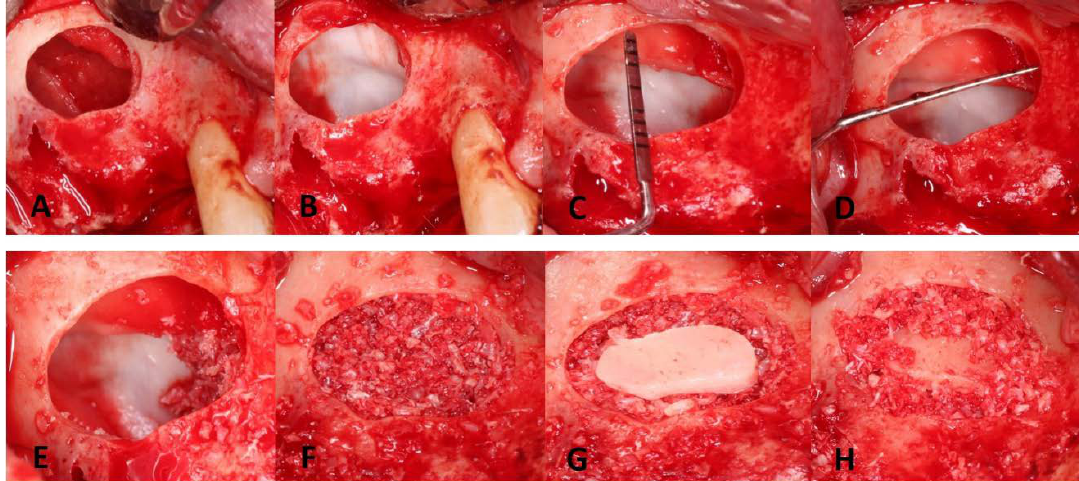
Figure 5. Membrane elevation with perforation repair and bone grafting: ( A ) sinus membrane elevation; ( B ) sinus repair with the first layer of CollaTape; ( C ) apico-occlusal dimension = 10 mm; ( D ) mesiodistal dimension = 10 mm with PRF membrane in place; ( E ) placement of a BioGide membrane to properly seal the perforation site. Note the bone graft on the anterior medial portion; ( F ) bone grafting of the surgical site well packed crestally; ( G ) the bony wall was placed over the lateral window, and then the crestal portion then the sinus cavity was filled; ( H ) bone graft around the bony island to stabilize the bony island.